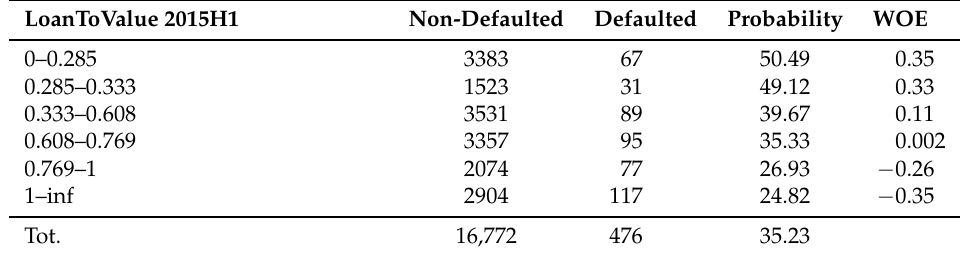
defaulted loans (column 3); probability, computed as the ratio between non-defaulted and defaulted (column 4) and Weight of Evidence (column 5). As we can see the application of the MAPA algorithm allows to cut the variable into classes with a monotone WOE. The table confirms the relation